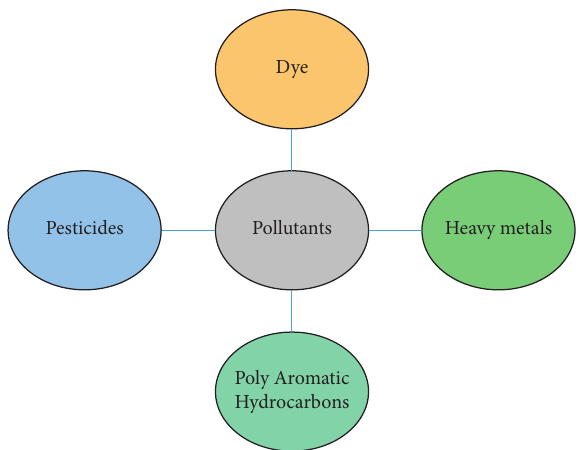
Figure 1: Types of